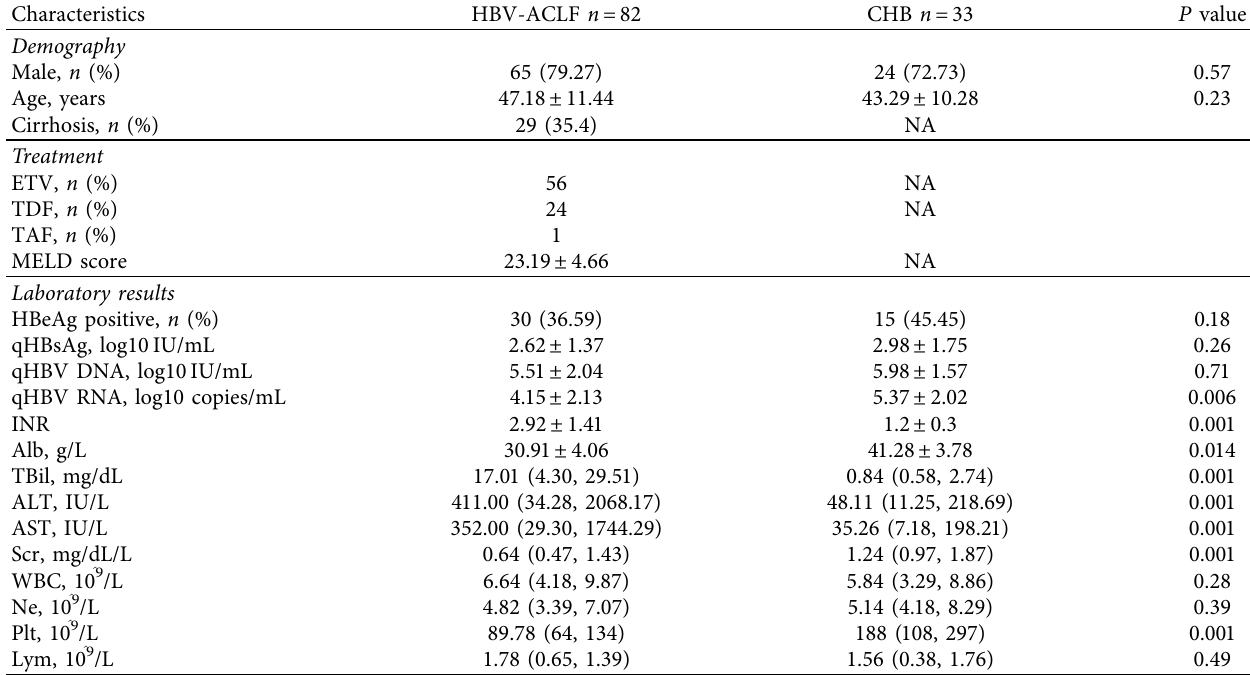
Table 1: The baseline characteristics of the